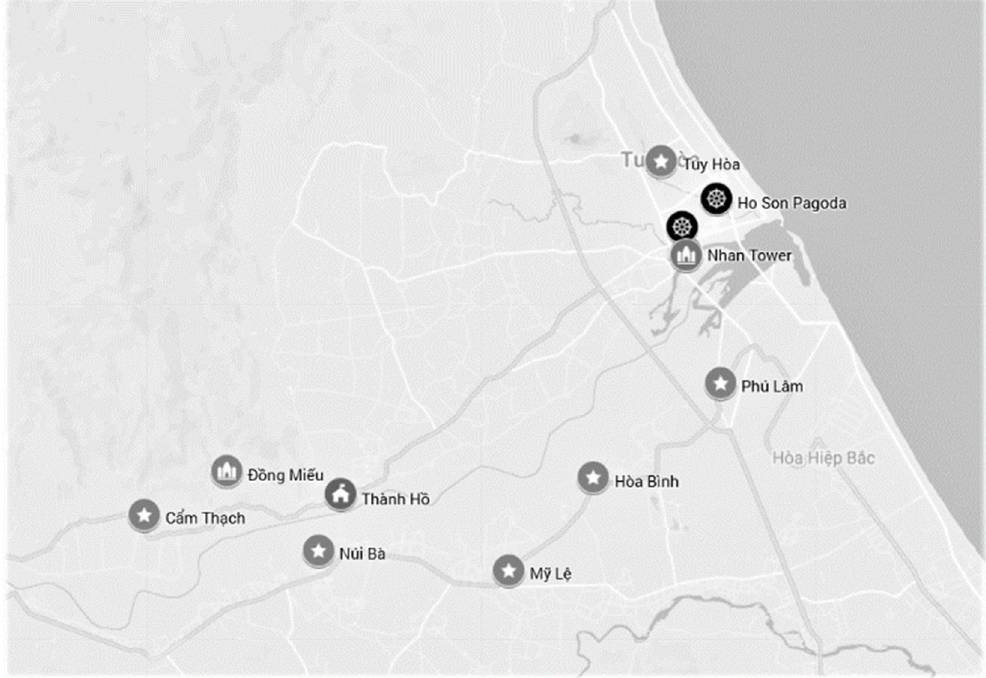
Figure 4. A collection of key archaeological sites in Phú Yên (Designed in Google Maps Nosewor-